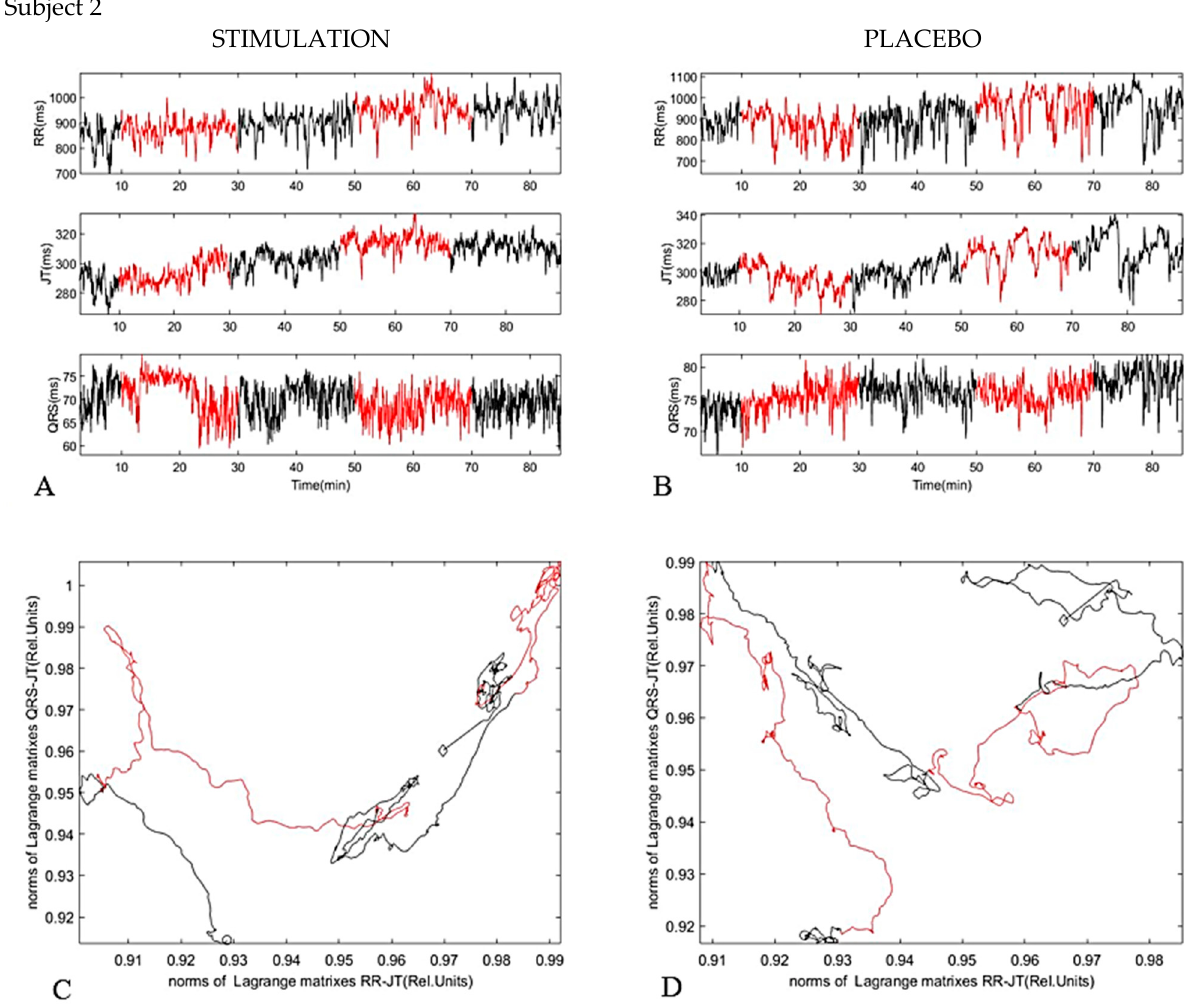
Figure 6. Subject 2. ( A ) dynamic of parameters RR interval, JT interval, and QRS duration during investigation (Stimulation). ( B ) dynamic of parameters RR interval, JT interval, and QRS duration during investigation (Placebo). ( C ) phase plane for JT/QRS and RR/JT norms during stimulation. ( D ) phase plane for JT/QRS and RR/JT norms during placebo.